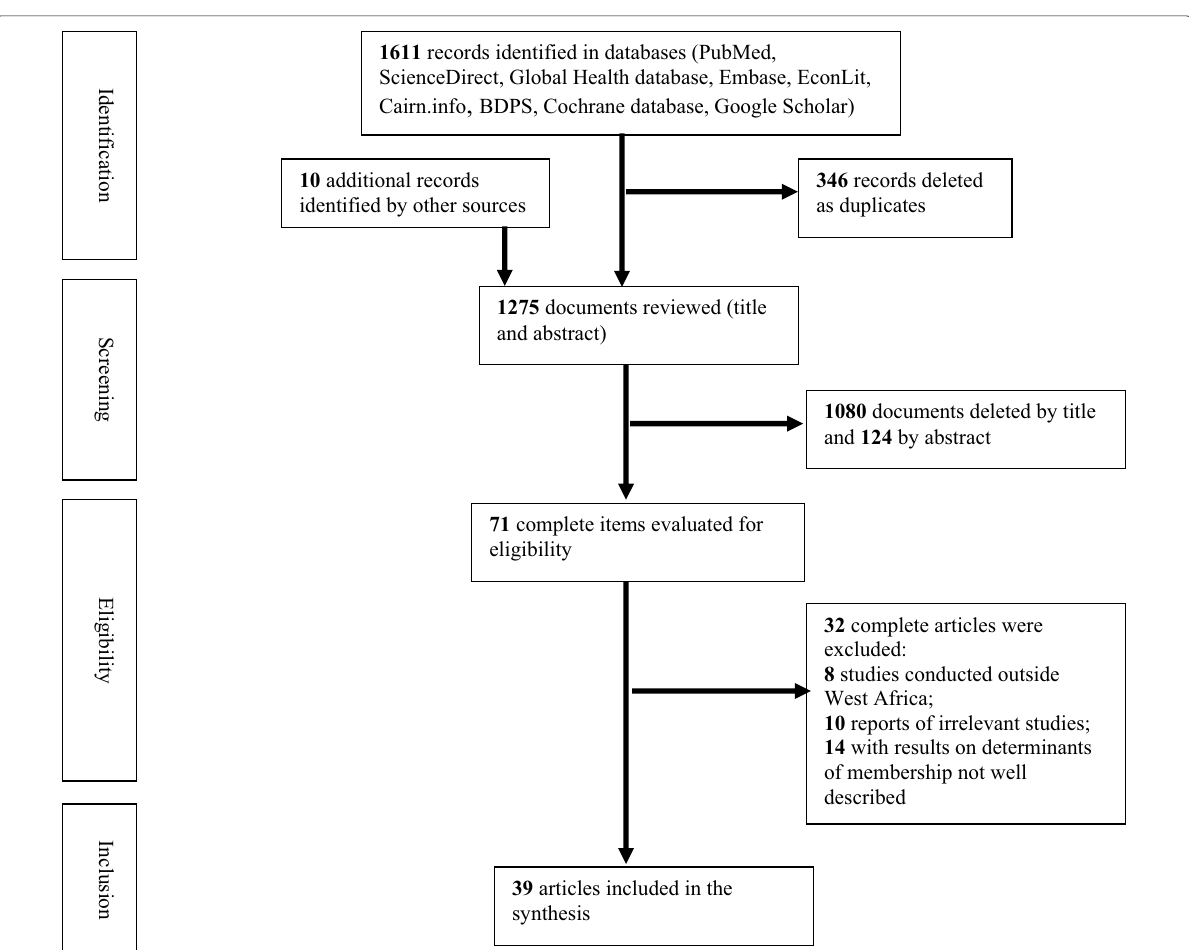
Fig. 1 PRISMA flow chart of the study selection process for examining the determinants of membership in community-based health insurance (CBHI) in West Africa